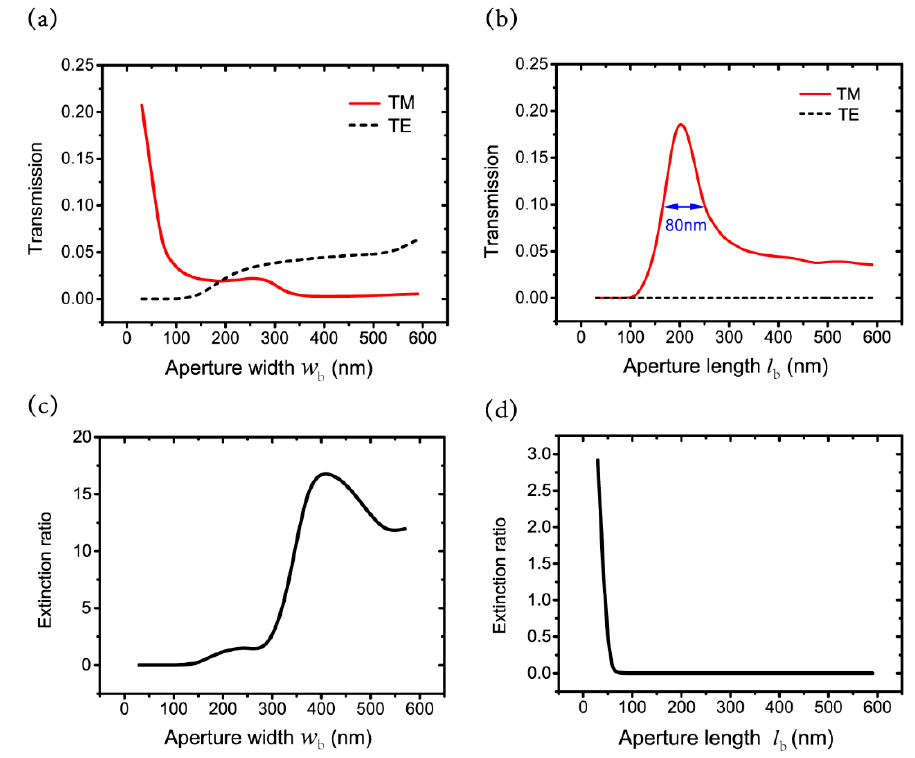
Figure 4. Transmissions with di ff erent ( a ) w b and ( b ) l b of the aperture for TM and TE polarizations; extinction ratio with di ff erent ( c ) w b and ( d ) l b .